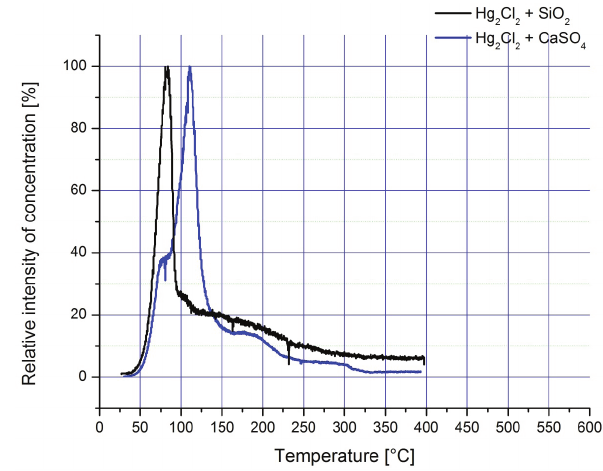
Figure 4: Thermograms of Hg